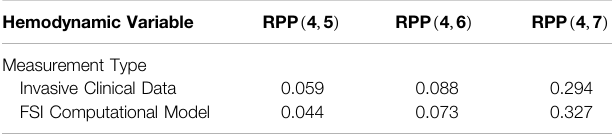
TABLE 2 | Comparison between invasive clinical measurements and the results from our computational model. Hemodynamic Variable